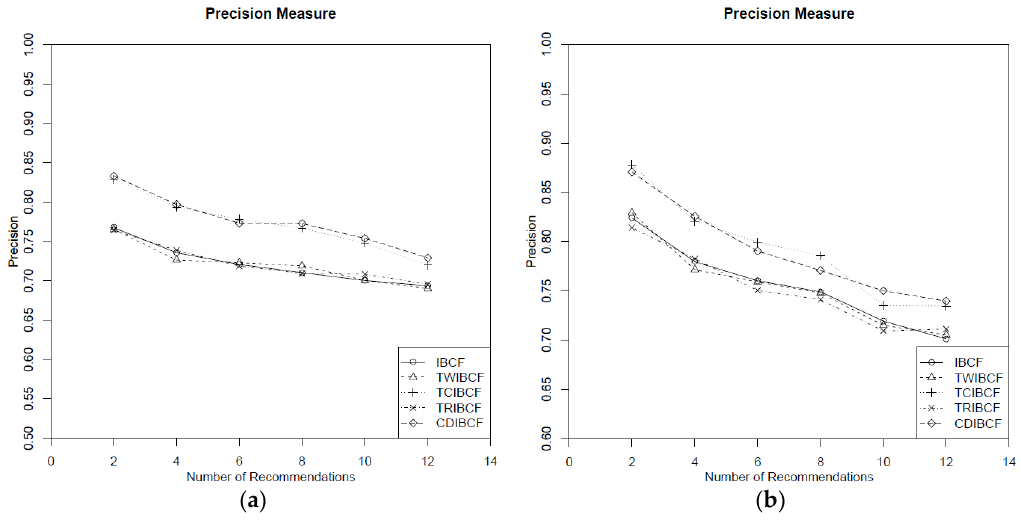
Figure 7. Precision results with MovieLens dataset ( a ) and Netflix dataset ( b ).